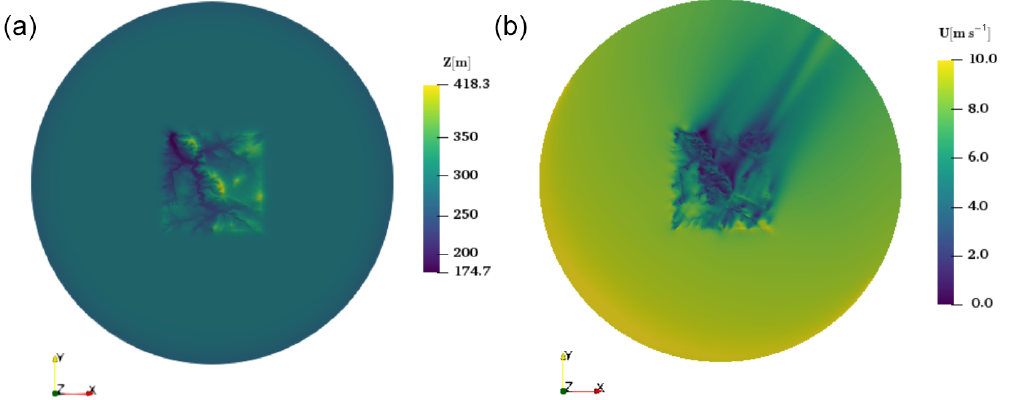
Figure 9. The cylindrical domain of the Kassel terrain (a) and the velocity field at the site at 40m perpendicular distance from the terrain’s surface points, which is simulated with WD = 213 ◦ (b) . This simulation was used as the reference for the calibration.